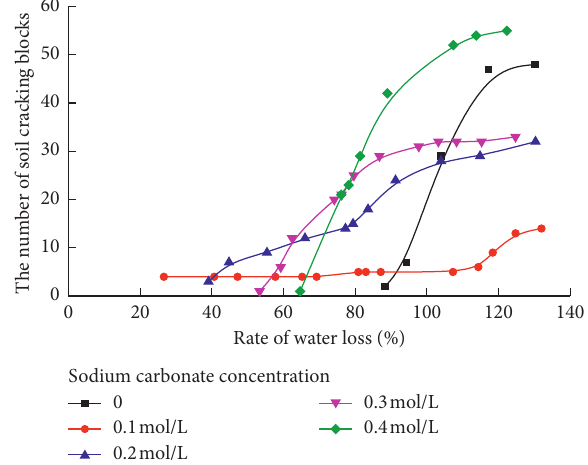
Figure 4: Relationship between the water loss ratio and the number of cracking blocks of the soil.